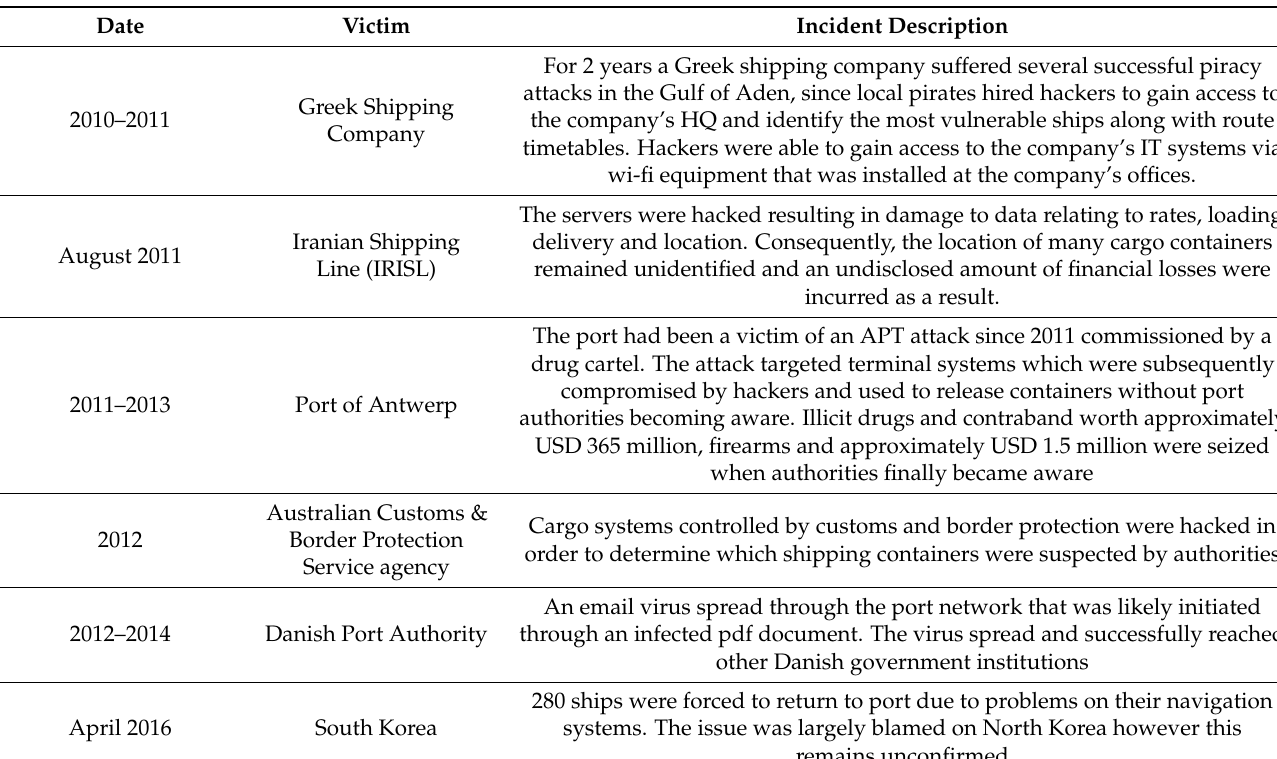
Table A1. Notable Maritime Related Cyber